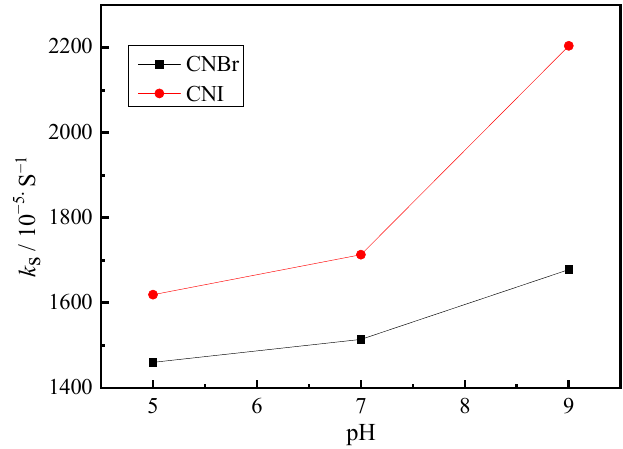
Figure 8. Effect of pH on the stability of CNBr and CNI.